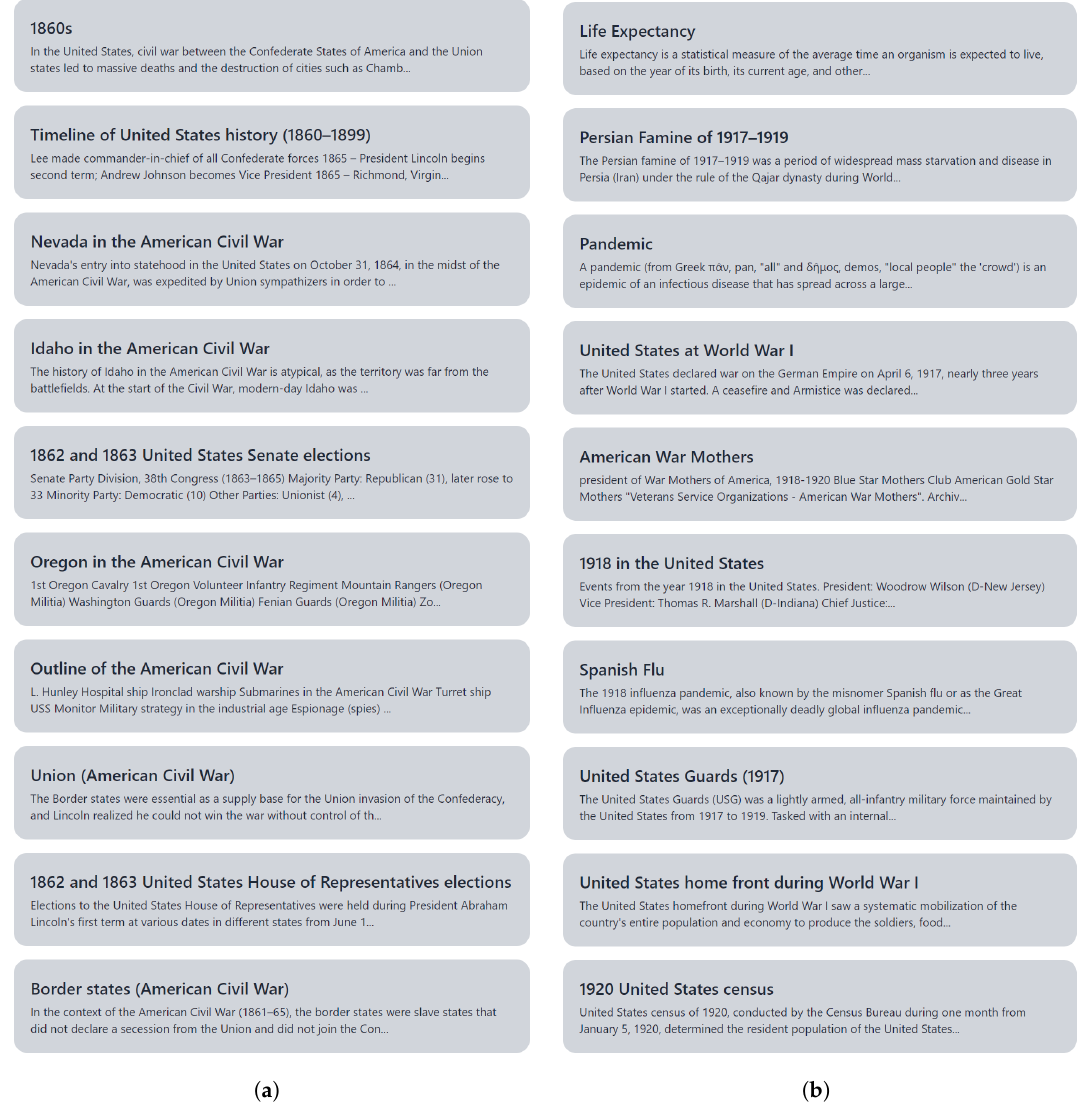
Figure 5. List of documents retrieved from Wikipedia related to the drop in the United States’ life expectancy. ( a ) Selection between 1860 and 1866. ( b ) Selection between 1917 and